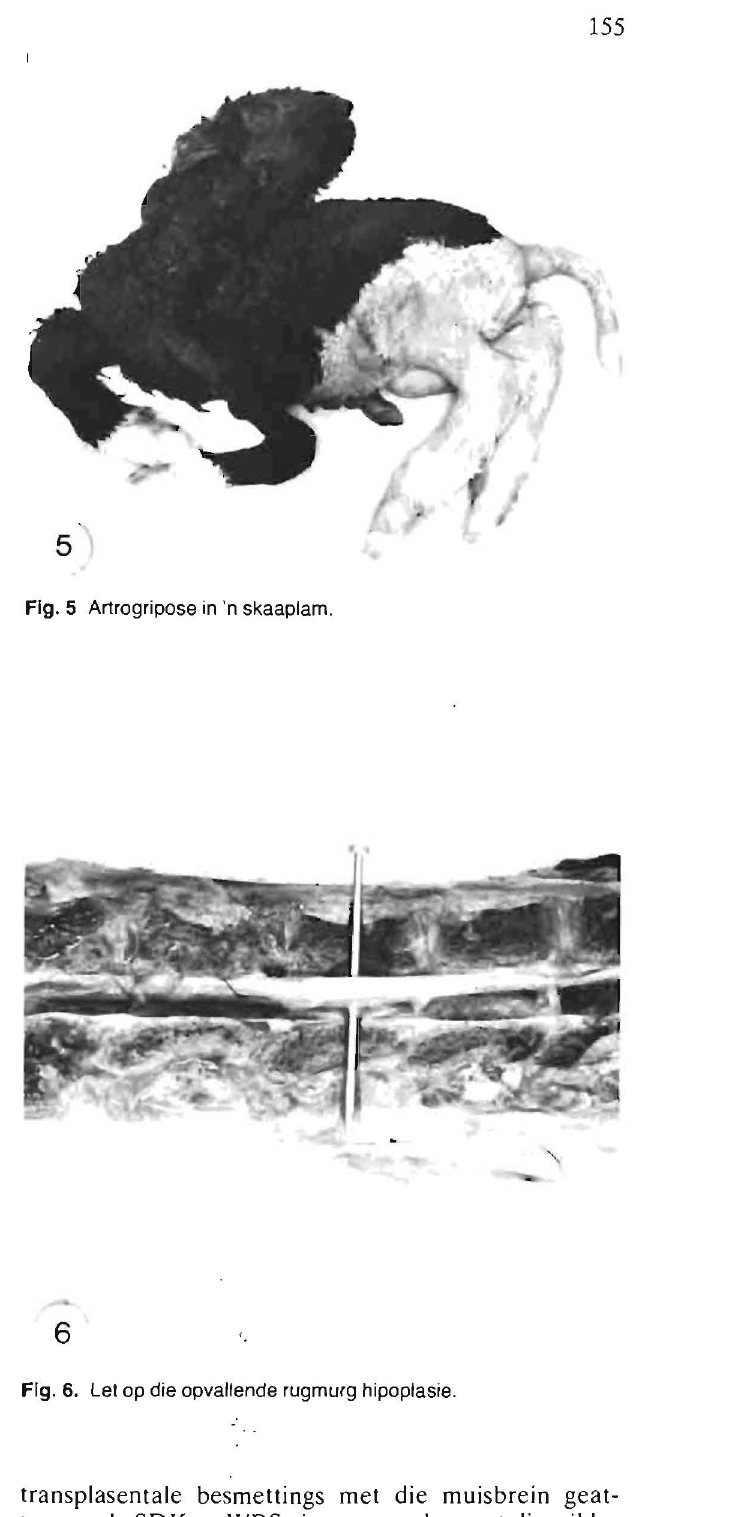
Fig. 5 Artrogripose in 'n skaaplam.